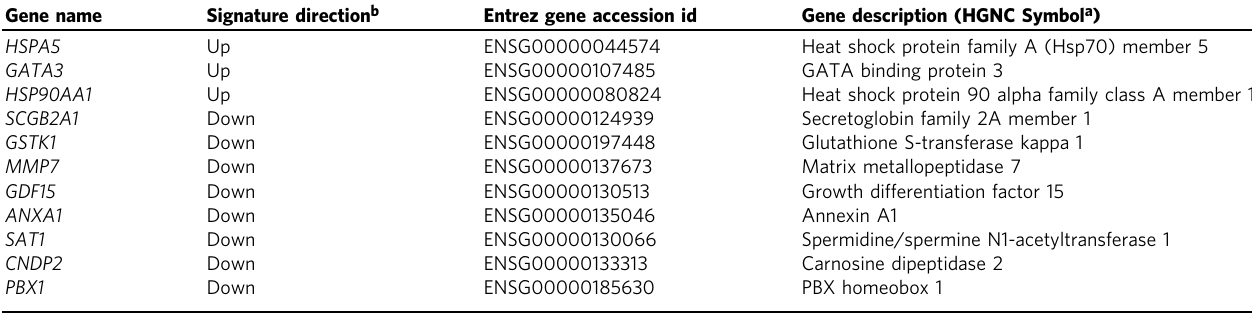
Table 2 List of 11 genes in